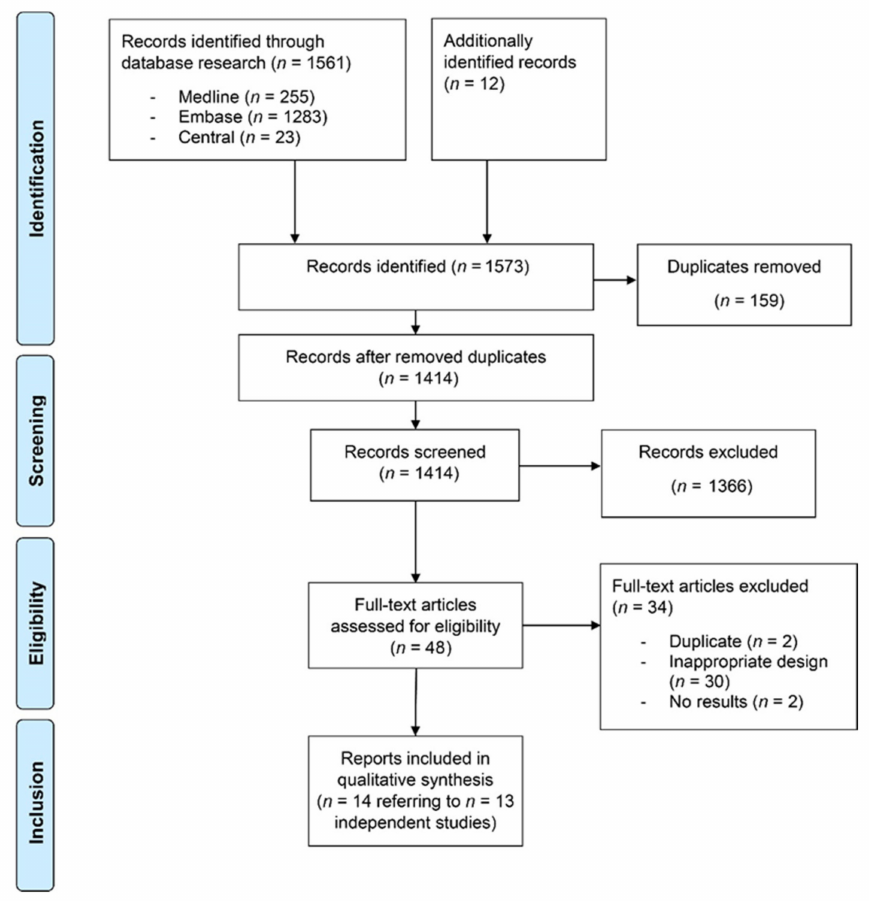
Figure 1. Flow chart of the literature identification process according to the PRISMA